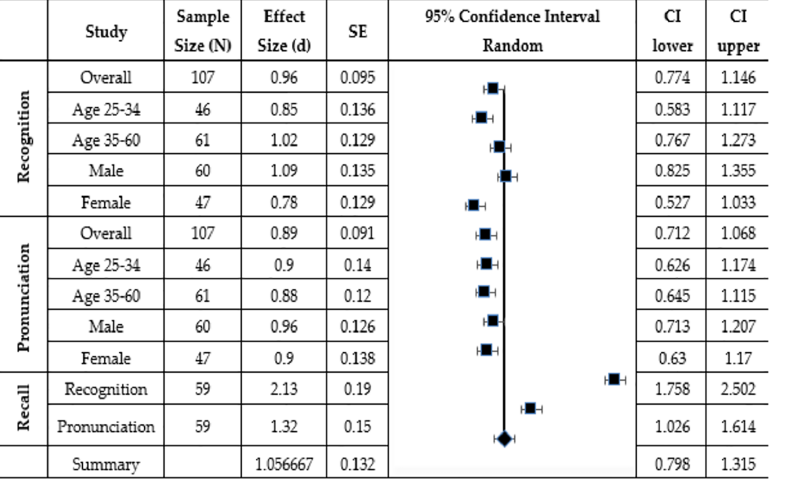
Fig 3. Meta–analysis